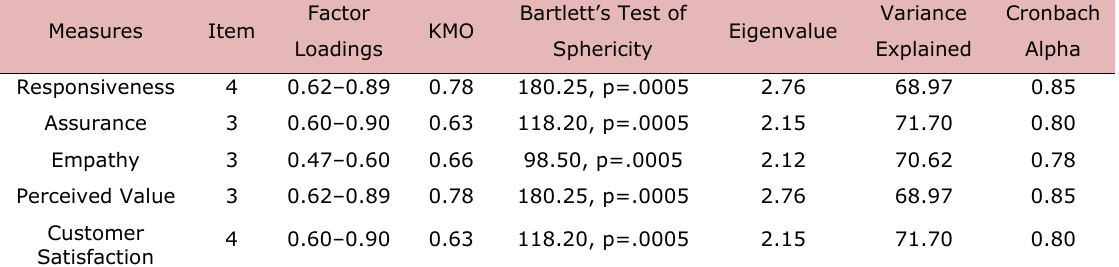
Table 4. “Results of validity and reliability